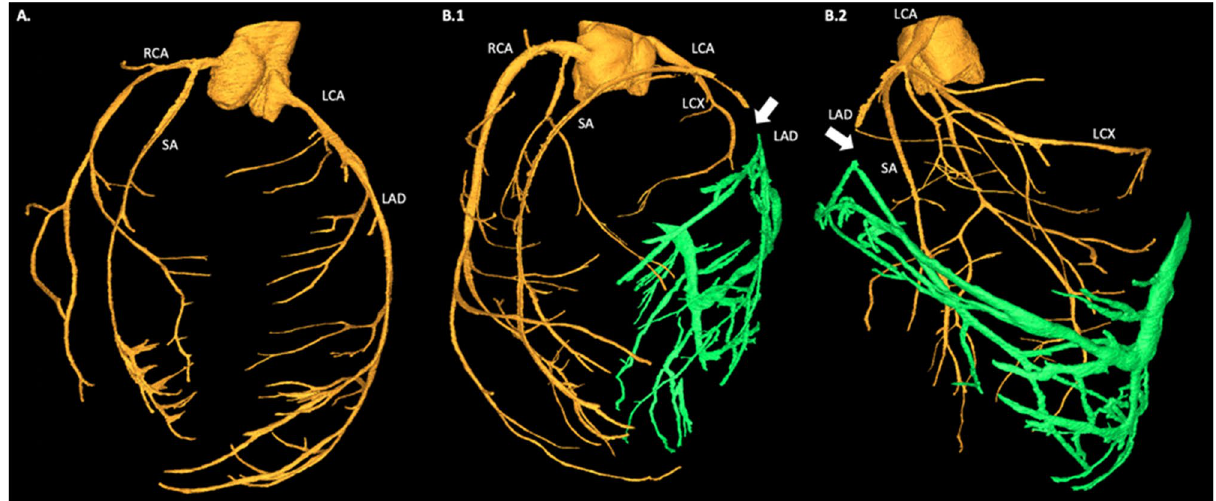
Figure 3. 3D Rendering of the segmented vascular tree. For this rendering one control heart from a healthy rat, and one infarcted heart from a rat with induced myocardial infarction was used. ( A ) Control rat heart. ( B.1 , B.2 ) Post-myocardial infarction heart. Coronary arteries branching is represented in yellow. Green color indicates increased vascular spaces in the infarct area. White arrow indicates site of left coronary artery ligation. RCA: right coronary artery, LCA: left coronary artery, SA: septal artery, LCX: left circumflex artery, LAD: left anterior descending